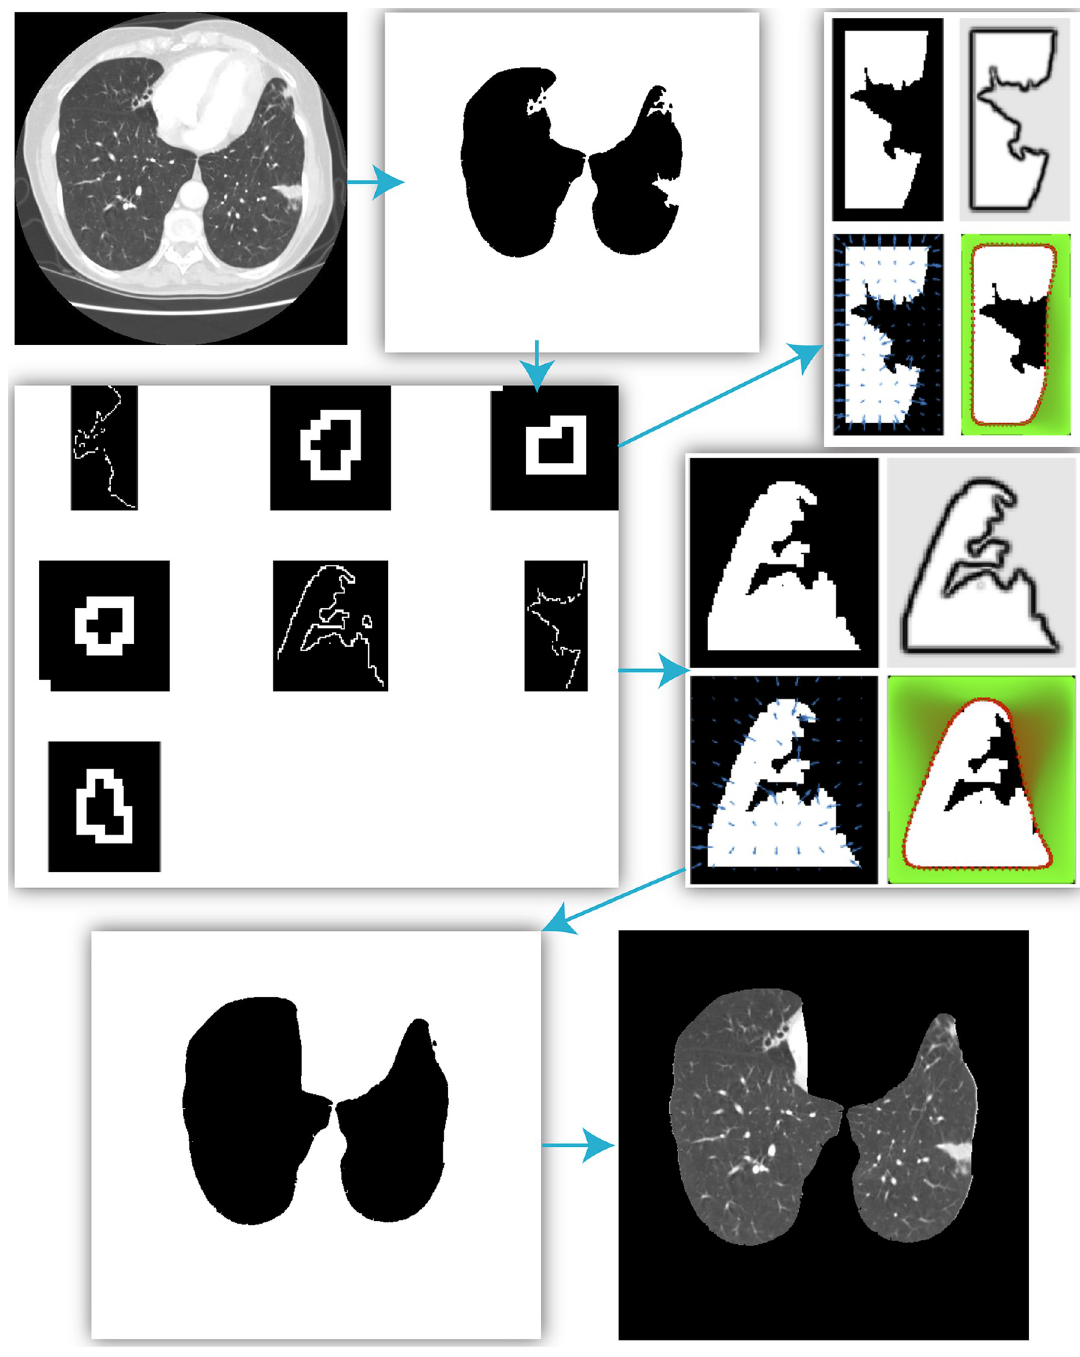
Fig 13. The segmentation results in the CT slice